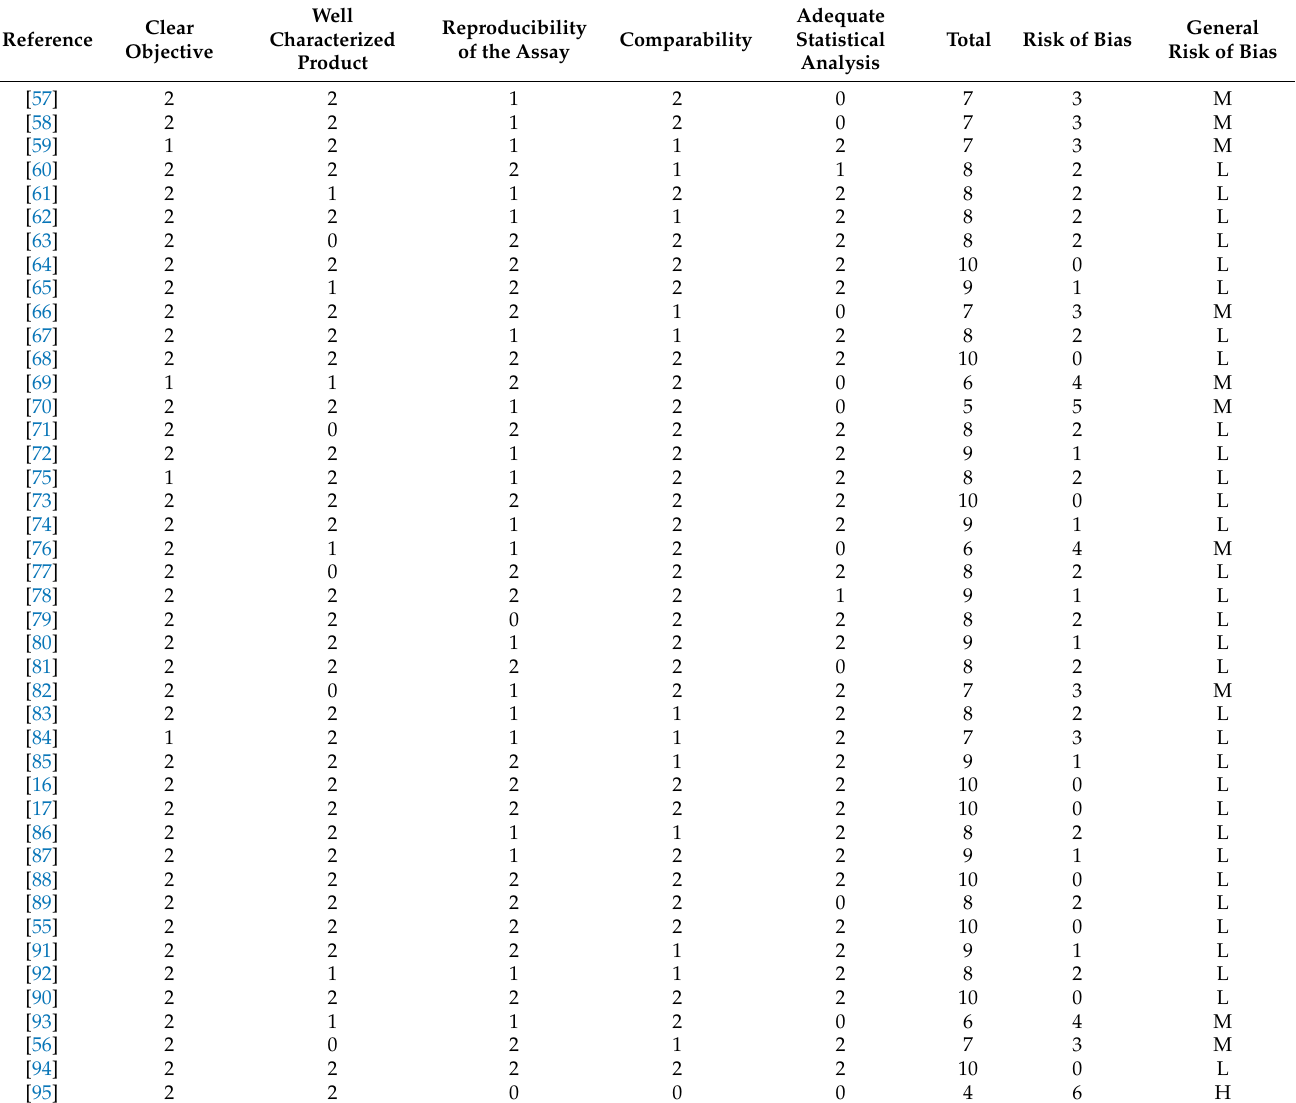
Table 3. Risk of bias for the methodological quality of studies reporting the toxicological evaluation in vitro of OSCs from Allium spp. 0: not reported; 1: not appropriately or clearly evaluated; 2: